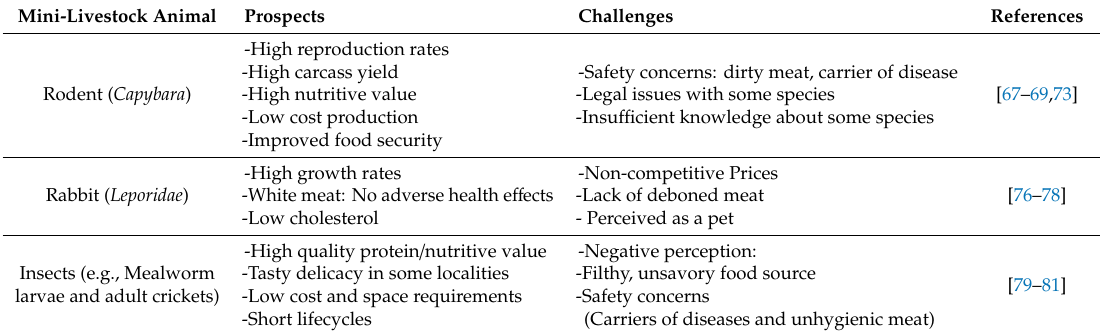
Table 4. Some examples of Mini-livestock animal derived (muscle and non-muscle)